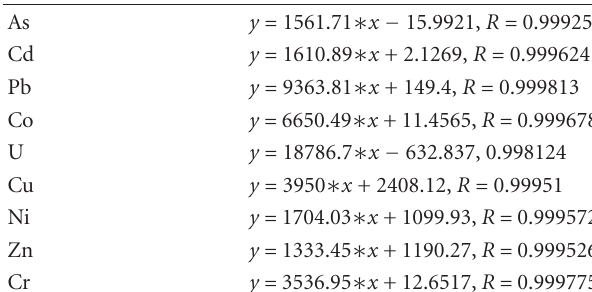
Table 2: Parameters of calibration curves for As, Cd, Pb, Co, U,